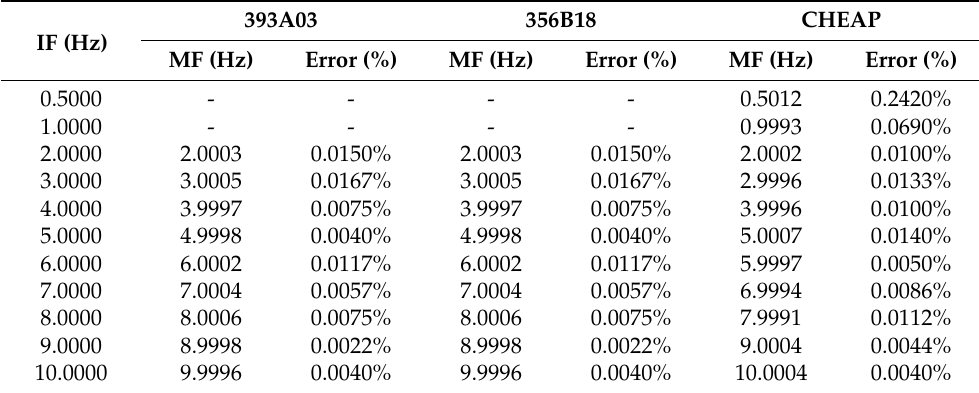
Table 3. Frequency extracted from the acquired accelerometers together with their error.